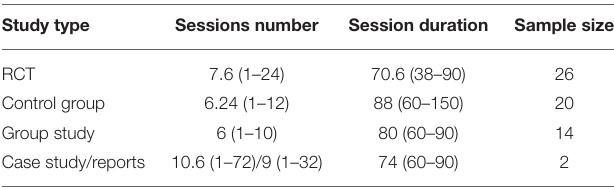
TABLE 3 | Summary of the distribution of session number, duration, and average sample size per study